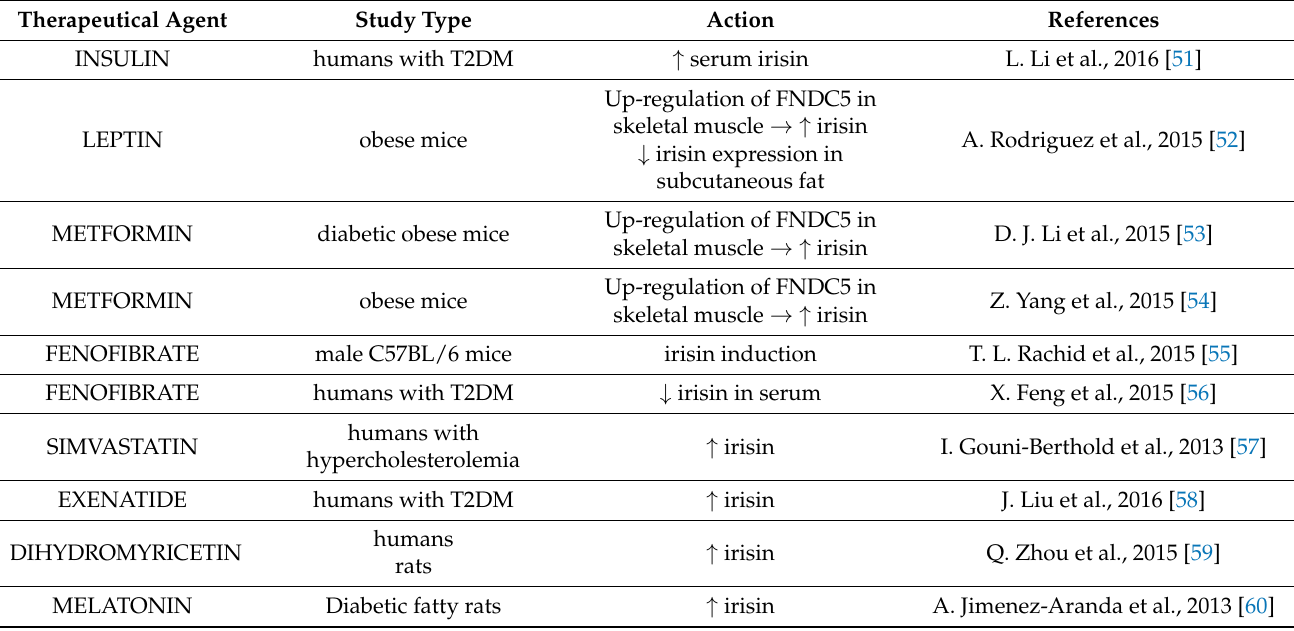
Table 2. The effects of pharmacological agents on